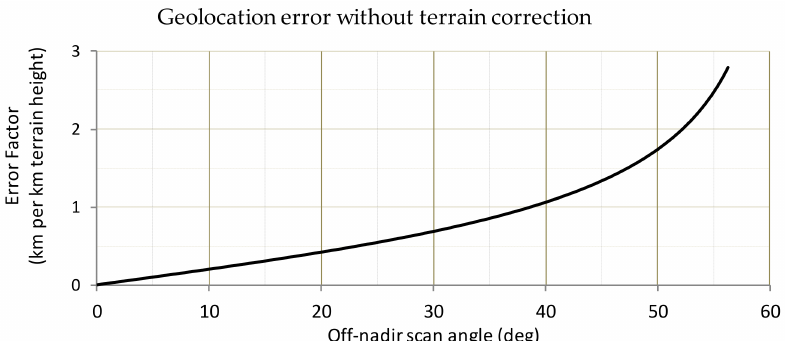
Figure 7. VIIRS parallax geolocation error from the ellipsoidal Earth model surface to the actual Earth terrain surface every one km of terrain height.